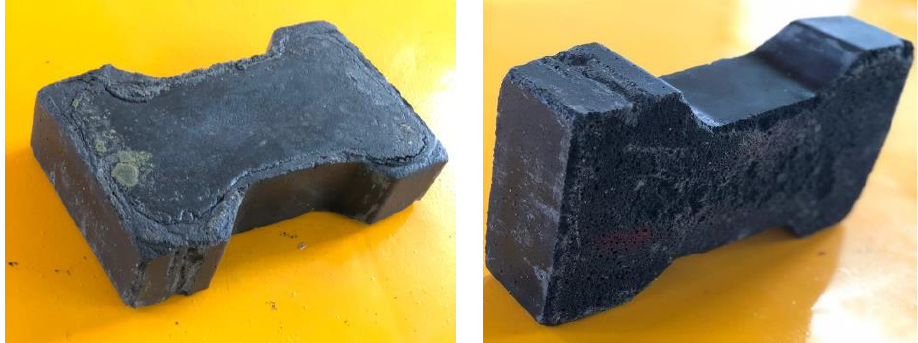
Figure 6. Product of the recycled plastic pavement fabrication process (70% LDPE, 30%